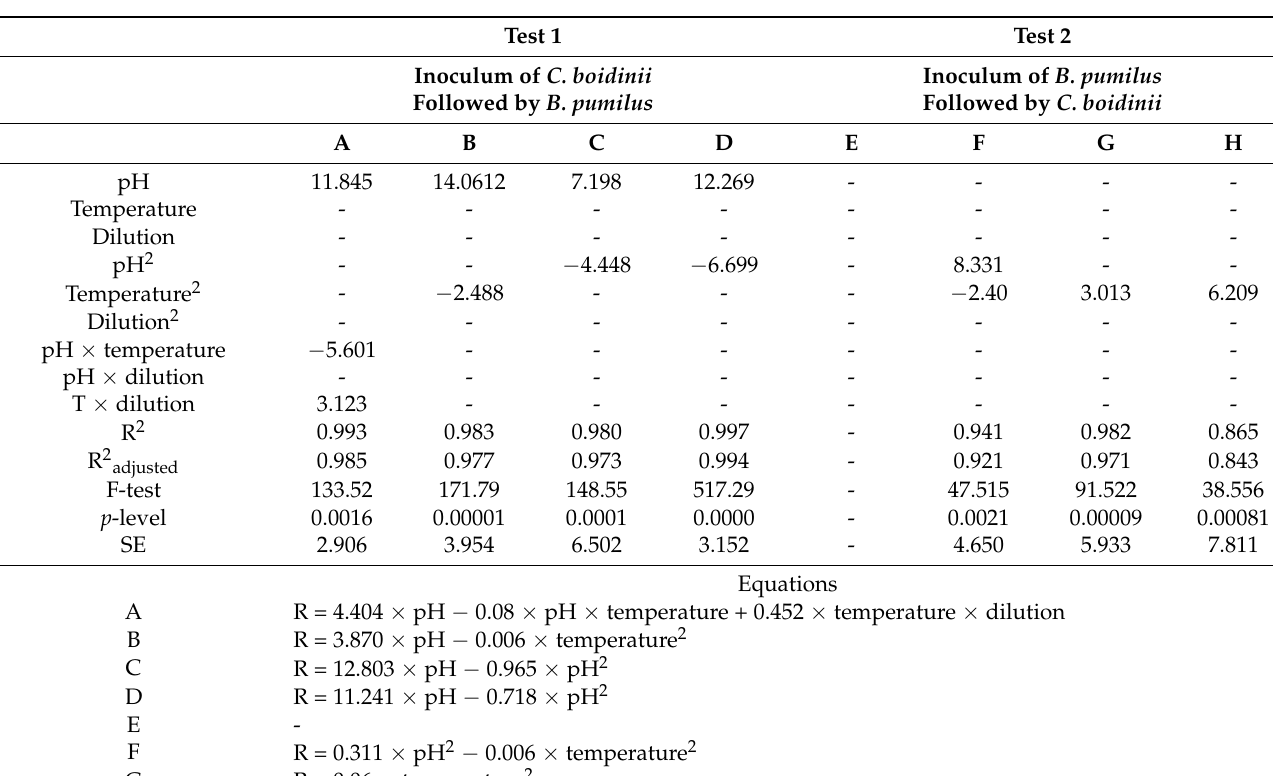
Table 3. Effect of pH, temperature and dilution ratio on phenol reduction by Bacillus pumilus and Candida boidinii sequentially inoculated (test 1 and test 2) in ATOPW and FTOPW. R 2 , determination coefficient; R 2 adjusted , determination coefficient adjusted for multiple regression; F-test, Fisher test value; SE, standard error of the